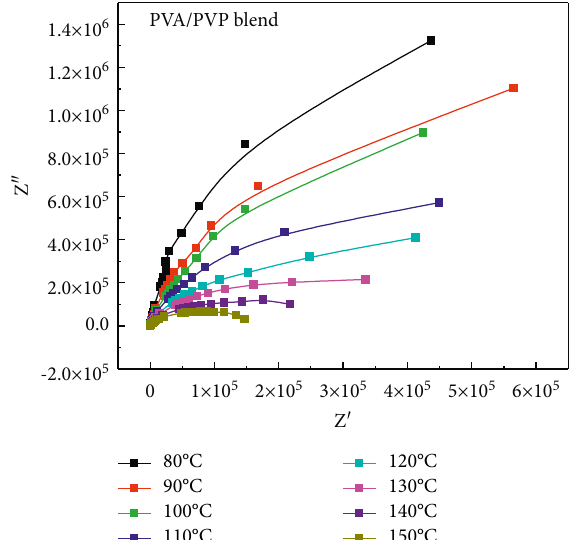
Figure 6: Complex plane plots (Z ′ -Z ″ ) for PVA/PVP polymer blend at various temperatures.